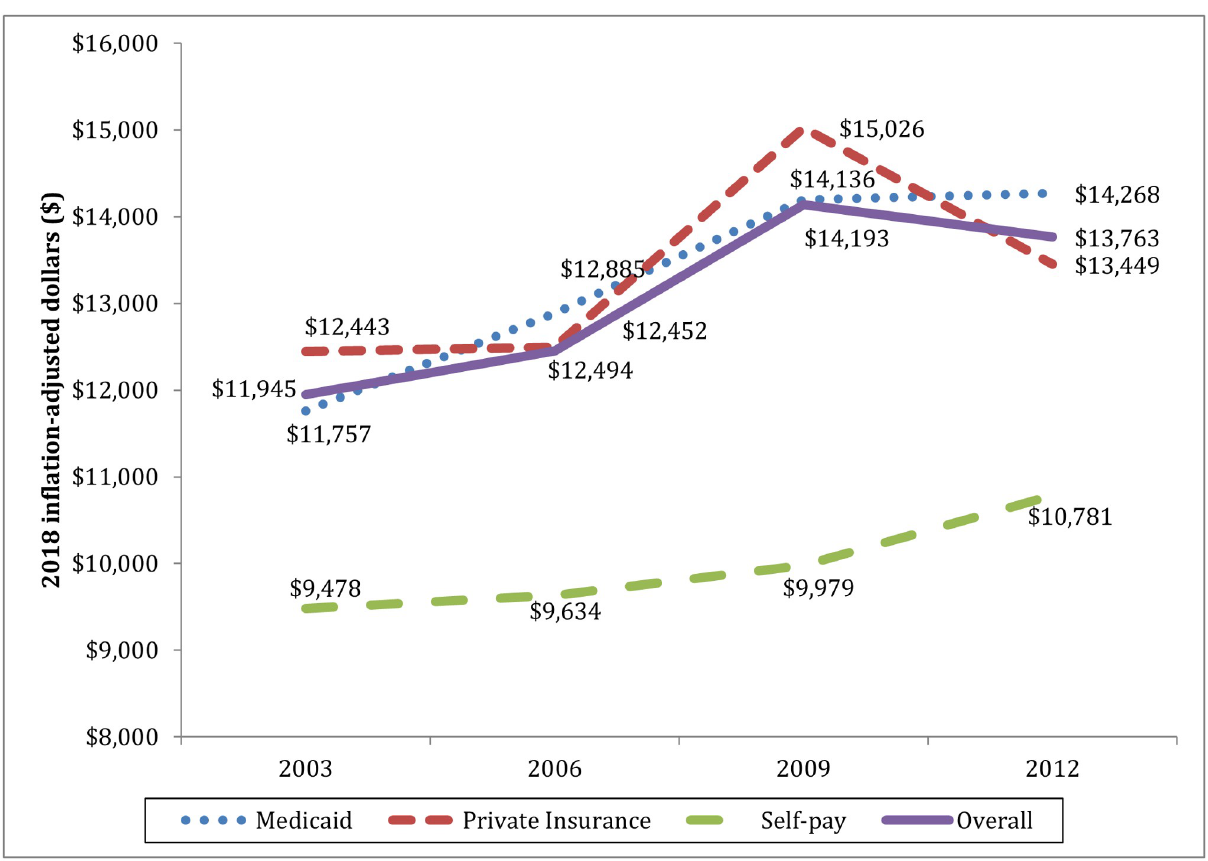
Fig 1. Average hospital cost per admission for pediatric firearm-related injuries by payer type. All data from